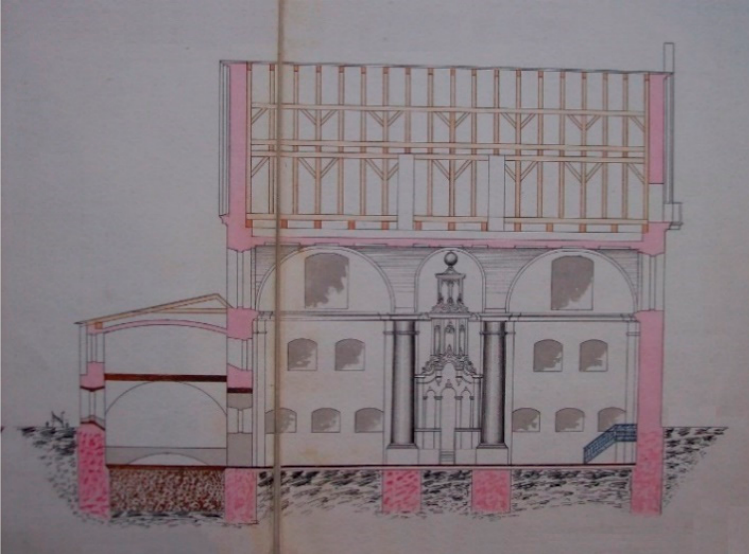
Figure 4. The Viner plan of the bimah —Leonid Viner. Drawing, 1893. LVIA, F. 382, Ap. 1, B. 1513, L. 2v. Public domain